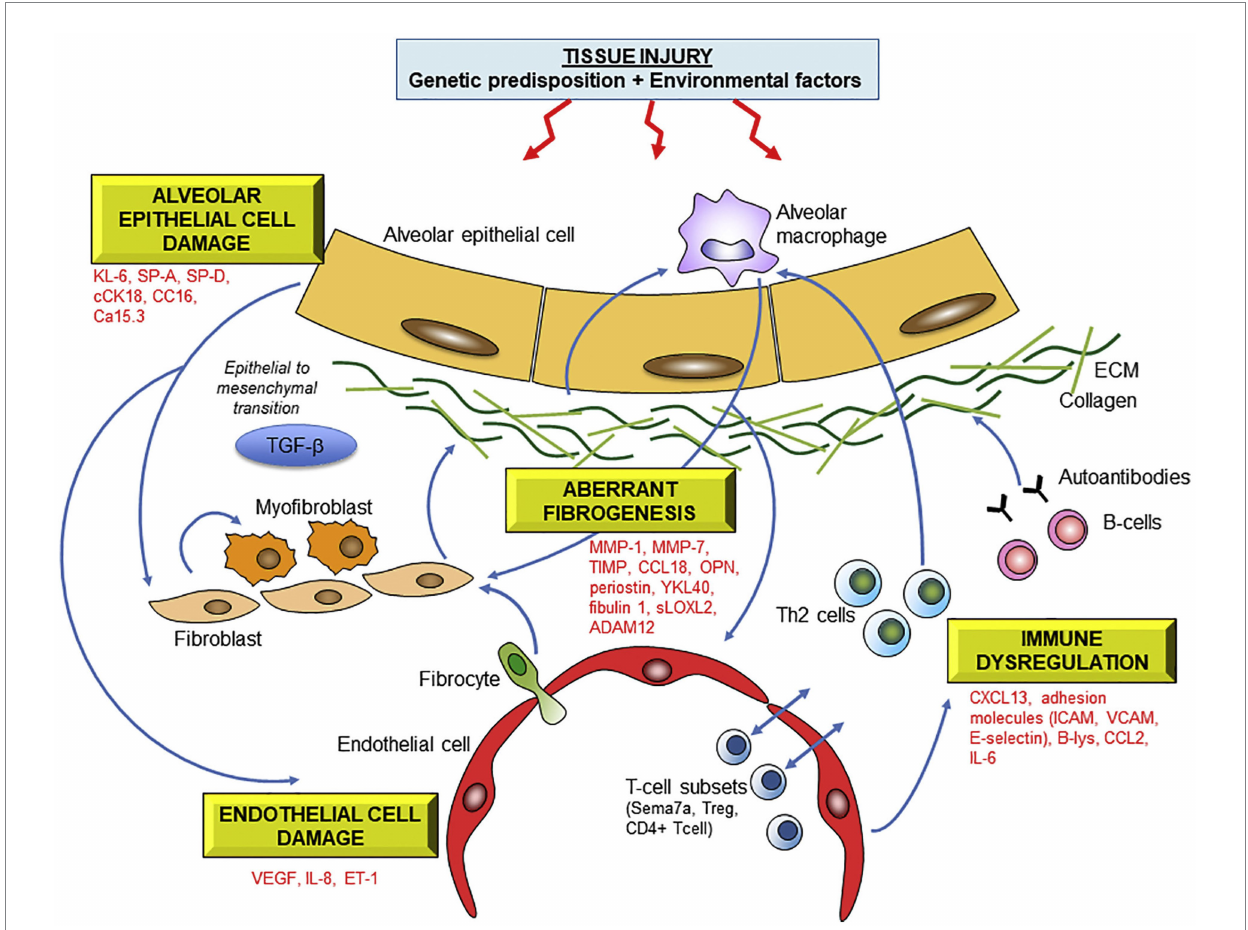
FIGURE 1 Molecular mechanisms underlying fibrotic lung injury and potential serum biomarkers of ILD. Abbreviations: KL-6 Krebs von lungen 6; SP-A/SP-D surfactant protein A/D; cCK18 cleaved cytokeratin 18; CC16 Clara cell protein 16; MMP matrix metalloproteinase; OPN osteopontin, HSP47 heat-shock protein 47; sLOXL2 serum lysyl oxidase-like 2; ADAM a disintegrin and metalloprotease; CCL18 chemokine ligand 18; ICAM intercellular adhesion molecule; VCAM vascular cell adhesion molecule; CXCL13 C-X-C motif chemokine 13; CCL2 CC chemokine 2; IL-6 interleukin-6. Reprinted from Pharmacology and Therapeutics, 202, Jee et al. (56), with permission from